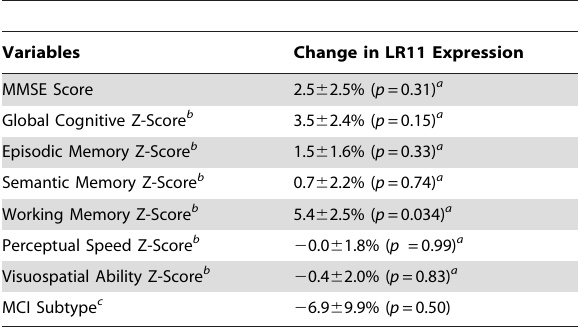
Table 4. Frontal cortex LR11 expression is not associated with cognitive performance or MCI